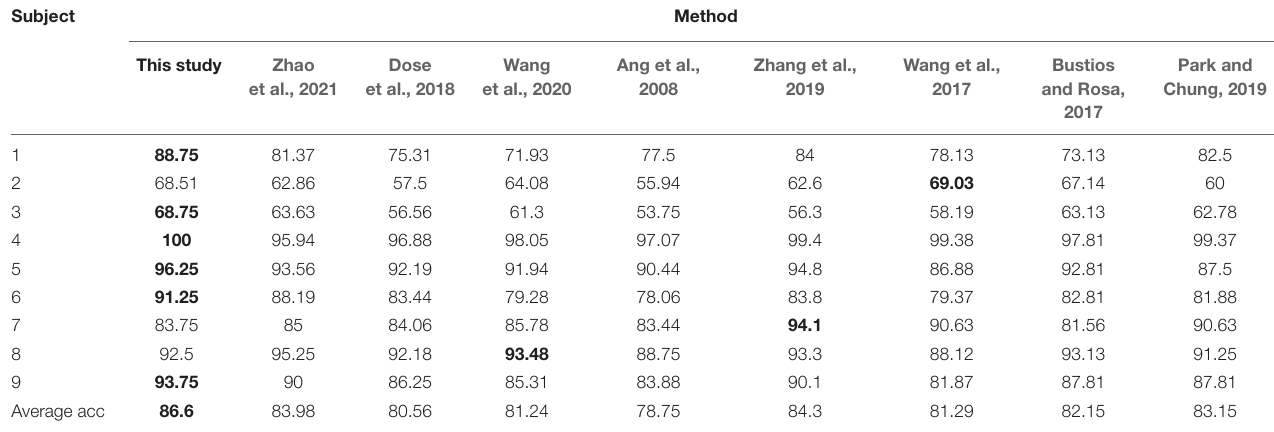
TABLE 7 | Comparison of classification accuracy between the method proposed in this study and existing methods on data set